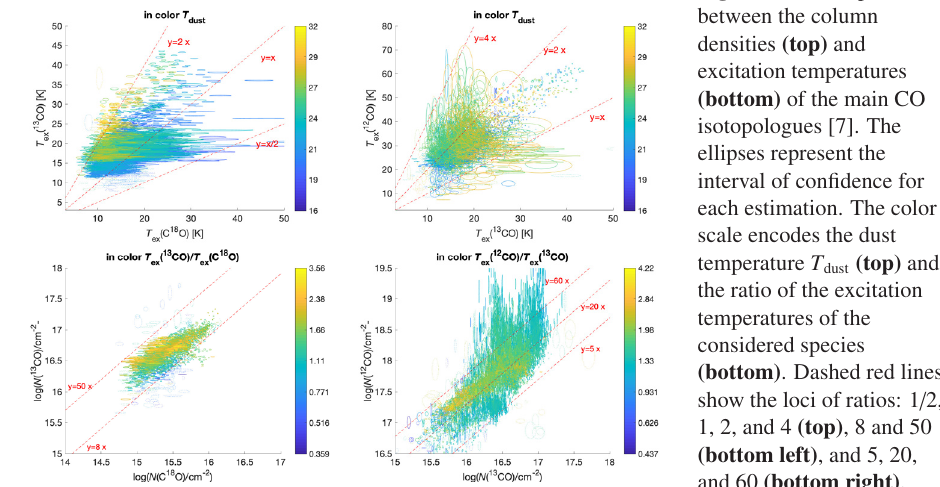
Figure 3. Scatter plots between the column densities (top) and excitation temperatures (bottom) of the main CO isotopologues [7]. The ellipses represent the interval of confidence for each estimation. The color scale encodes the dust temperature T dust (top) and the ratio of the excitation temperatures of the considered species (bottom) . Dashed red lines show the loci of ratios: 1 / 2, 1, 2, and 4 (top) , 8 and 50 (bottom left) , and 5, 20, and 60 (bottom right) .